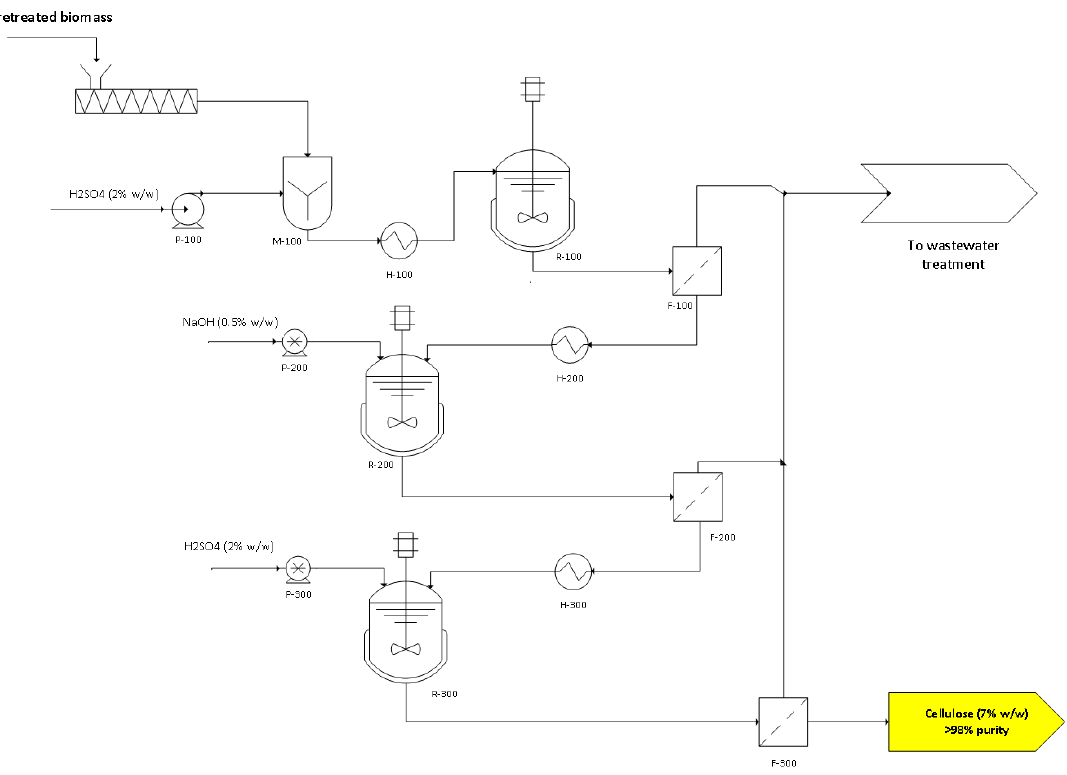
Figure 3. Process flow diagram for the acid-alkali-acid conditioning of the pretreated biomass based on reference [14] (equipment designation: P-X00, impulsion pump; M-X00, mixing vessel; H-X00, heat exchanger; R-X00, reactor; F-X00, membrane operation unit).